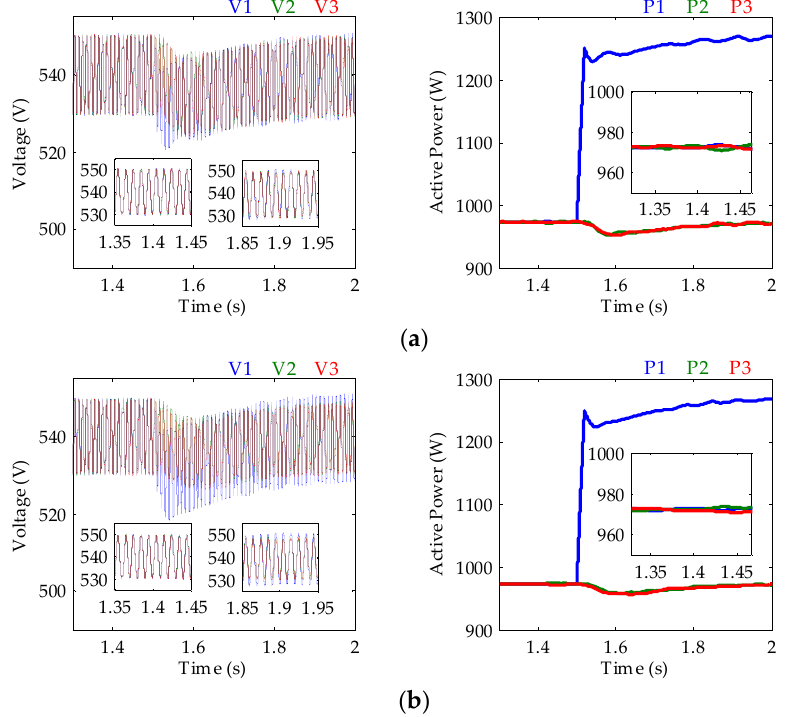
Figure 11. Simulation waveforms of dc-link voltage and active power of CHBR modules under load variation by use of ( a ) the proposed control strategy and ( b ) the conventional control strategy.